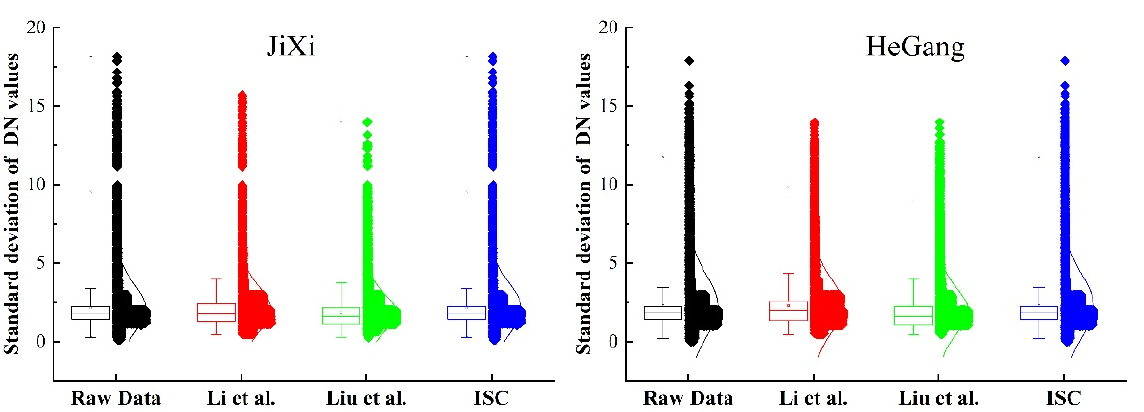
Figure 10. Standard deviation box plots of three different calibration methods in Jixi and Hegang cities.